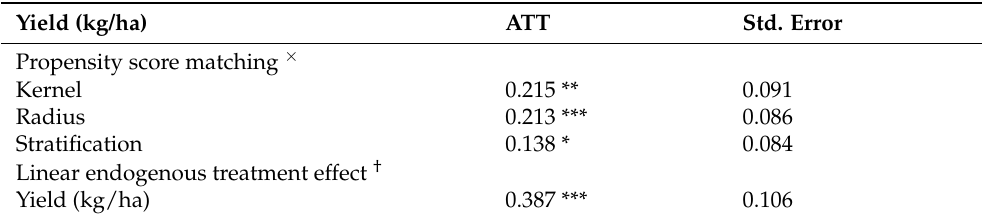
Table 4. Effects of improved maize varieties adoption on productivity.